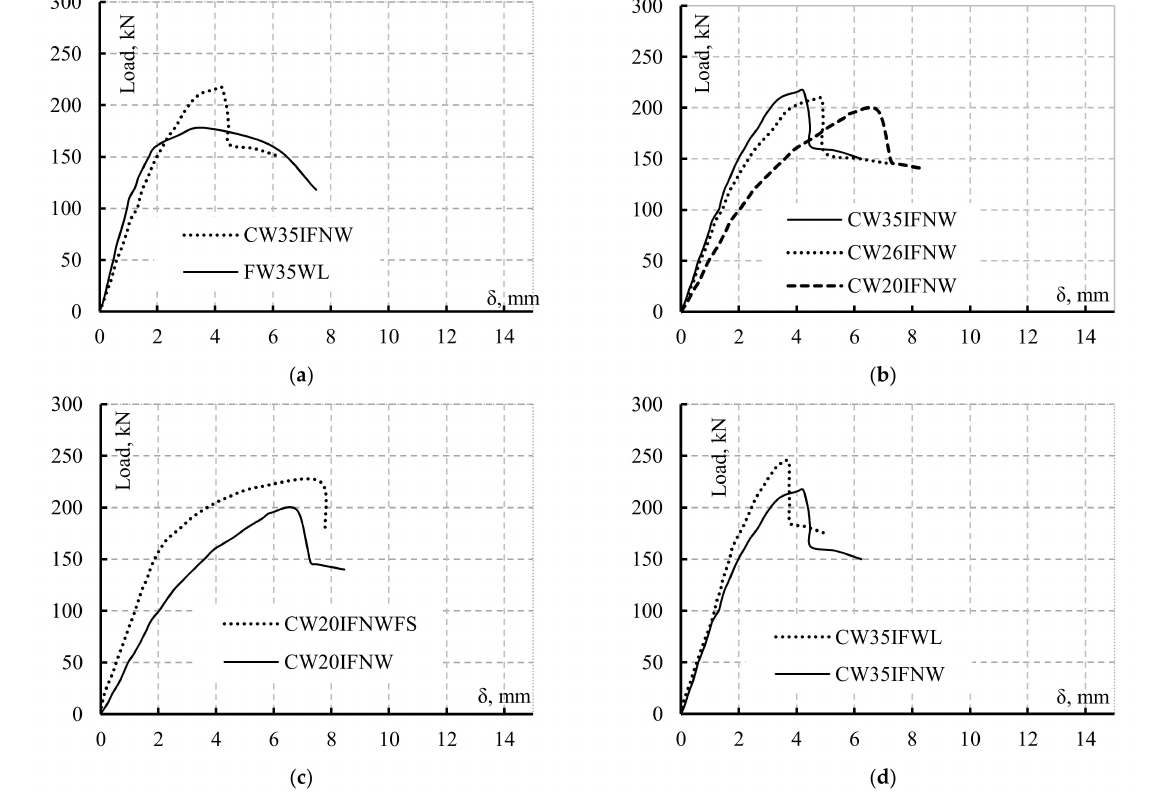
Figure 11. Mid-span vertical deflection vs. vertical loads of the tested beams: ( a ) Effect of the web conditions; ( b ) Effect of the HF length; ( c ) Effect of the stiffeners; ( d ) Effect of the welding